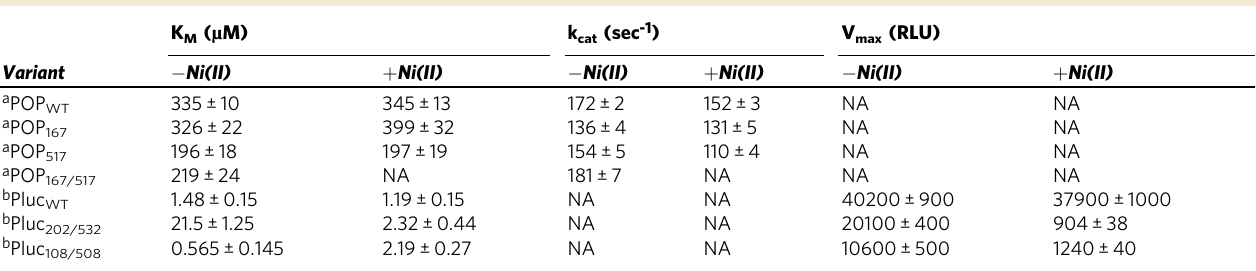
Fig. 3 Kinetic analysis of POP X/Y variants in response to divalent metals. a , b The activity of POP X/Y variants from CFPS was assessed on Z-Ala-Pro- p NA. a Reaction rates (AU/min) at increasing Ni(II) concentrations (0 – 100 µ M). The fold-changes between 0 and 10 µ M of Ni(II) for POP 167/517 , POP 167/513 , POP 169/512 , POP 169/510 , and POP 159/517 are noted. b The reversibility of metal-dependent activity upon addition of EDTA shows near-quantitative recovery for Ni(II), Cu(II), Co(II), and Zn(II), while activity is not recovered for changes by Fe(II), Select variants from Fig. 3a are shown. c Steady-state kinetic assays performed at 85°C using puri fi ed enzymes (~20 nM) in the presence of either 1 mM EDTA (black) or 5 µ M NiCl 2 (green). Initial rates ( µ M/sec) are plotted versus substrate concentration (mM), and data was fi t, when appropriate, with the Michaelis – Menten equation. The fold-change between reaction rate at 1 mM substrate is shown. Each data point represents the average of 3 replicates and error bars represent standard deviations. Source data are provided as a Source Data fi le. Table 1 Steady-state kinetic parameters for selected POP and Pluc